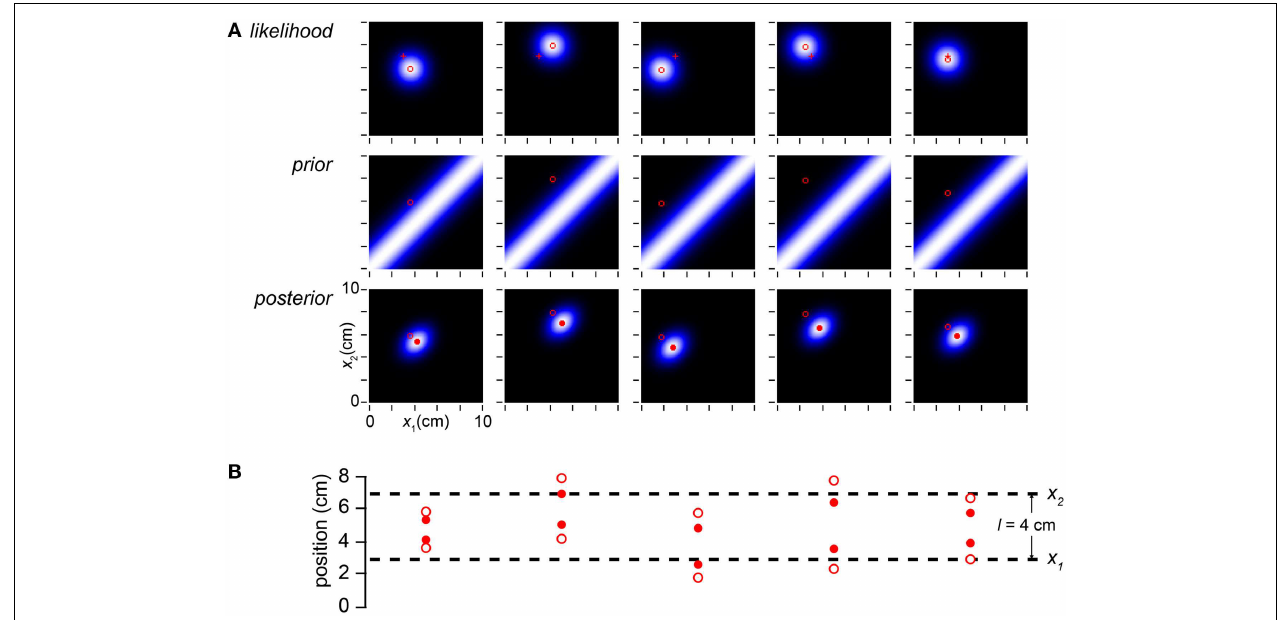
Consequently, the observer’s percept (mode of the posterior, filled red circle) varies stochastically from trial to trial. (B) The measured tap positions (open circles) and perceived tap positions (mode of posterior, filled red circles) on each trial, compared to the actual tap positions (dashed lines). On every trial, the perceived trajectory length ( l *, distance between filled circles) underestimates the measured length ( l m , distance between open circles); the perceived trajectory length therefore on average underestimates the actual trajectory length ( l